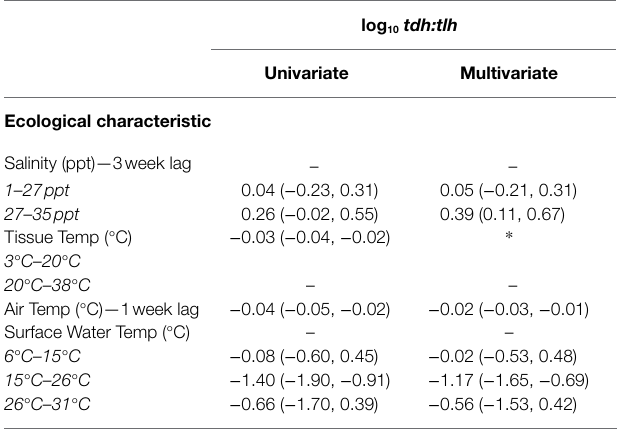
TABLE 4 | Model random effects for zone and sample site year group (SSYG). Random